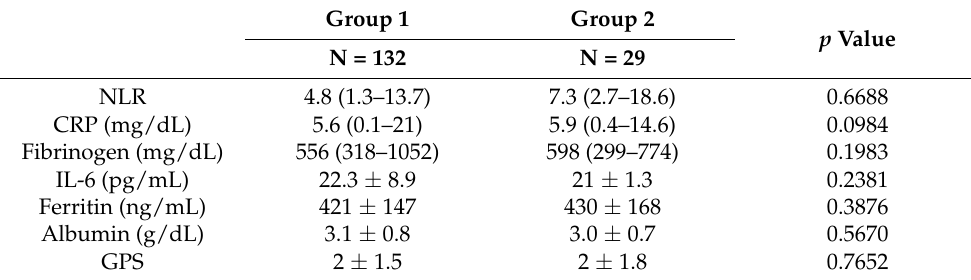
Table 2. Baseline laboratory parameters of the enrolled